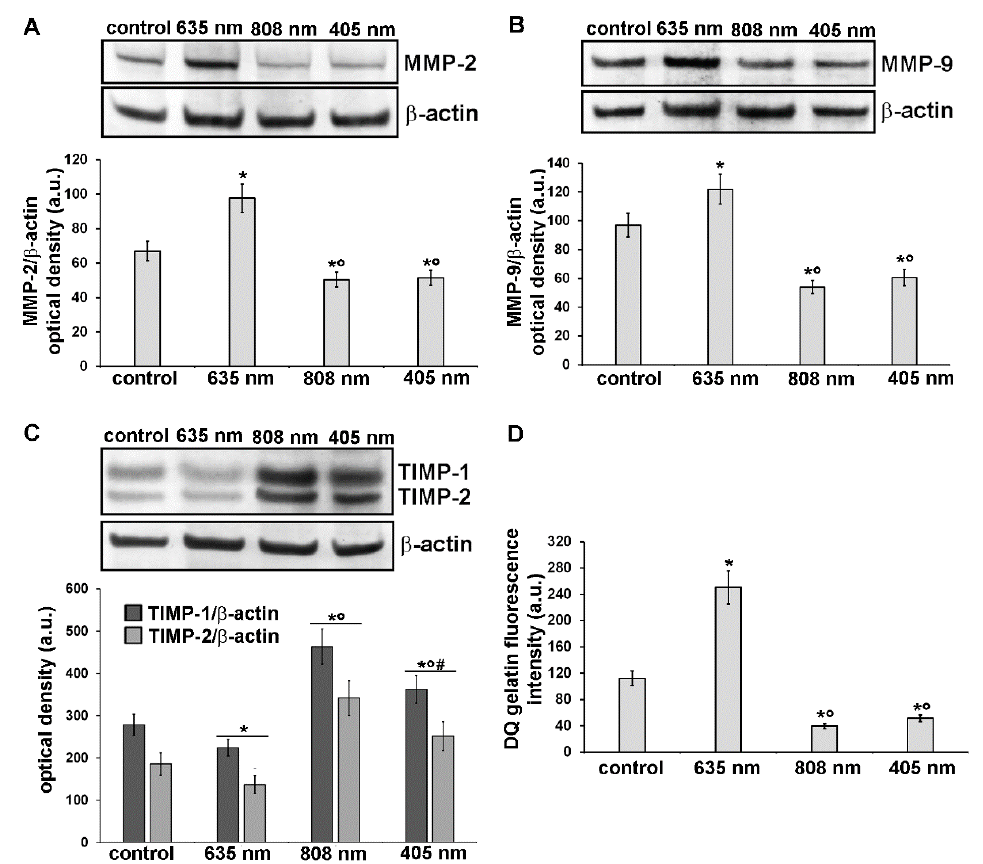
Figure 10. Analysis of the expression and activity of MMP-2 and MMP-9 and of the expression of their inhibitors, TIMP-1 and TIMP-2, in NIH / 3T3 fibroblasts 24 h after cell exposure to red (635 nm), NIR (808 nm) and violet-blue (405 nm) PBM. Cells not subjected to PBM treatments served as control. ( A-C ) Representative blots of western blotting analysis of ( A ) MMP-2 (72 KDa), ( B ) MMP-9 (82 KDa), ( C ) TIMP-1 (26 KDa) and TIMP-2 (21 KDa). The densitometric analysis of the bands normalized to β -actin (42 KDa) are reported in the histograms. ( D ) Gelatinase assay. NIH / 3T3 fibroblasts were seeded on a fluorescein-labeled gelatin substrate (DQ TM gelatin). DQ TM gelatin fluorescence signal intensity (515 nm), resulting from the digestion of the gelatin by MMPs’ activity, was quantified by a spectrophotometer. Significance of difference in A: * p < 0.01 vs . control; ○ p < 0.01 vs. 635 nm; p = 0.6, 405 nm vs. 808 nm. Significance of difference in B: * p < 0.01 vs. control; ○ p < 0.01 vs. 635 nm; p = 0.59, 405 nm vs. 808 nm. Significance of difference in C: * p < 0.01 vs . relative control; ○ p < 0.01 vs. relative 635 nm; # p < 0.01 vs . relative 808 nm. Significance of difference in D: * p < 0.01 vs . control; ° p < 0.01 vs. 635 nm; p = 0.26, 405 nm vs. 808 nm.